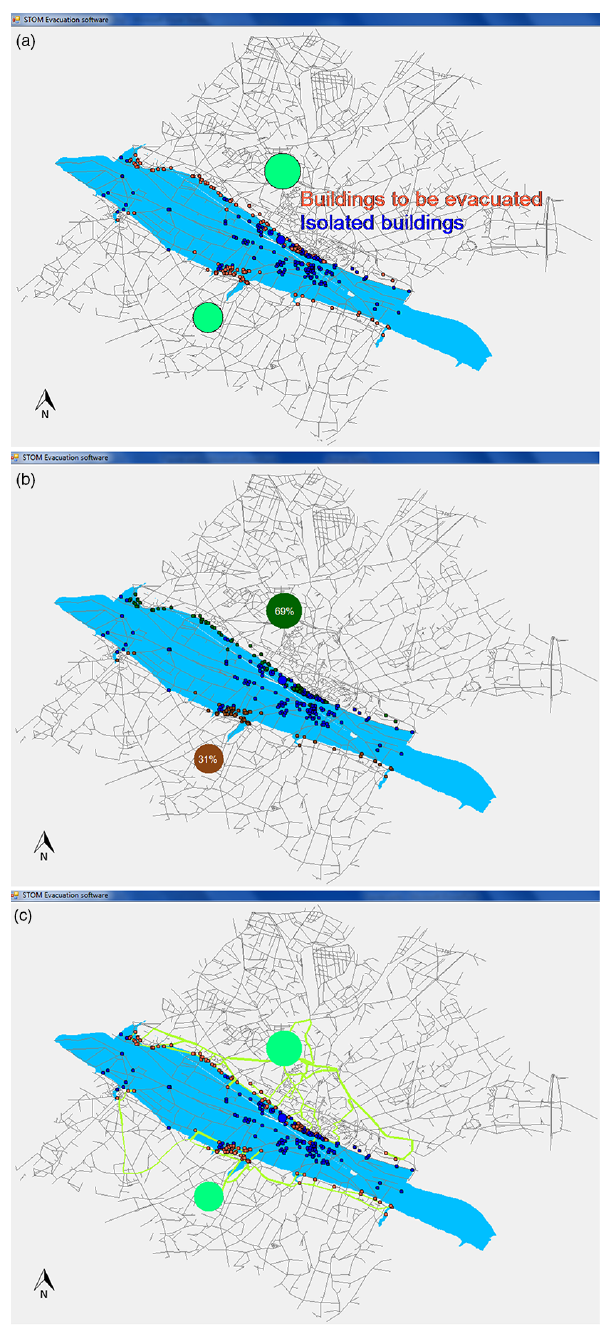
Figure 17. (a) shows the buildings to be evacuated (in red) and iso- lated buildings (in blue) 125h after the beginning of the flood, while (b) shows assignment of buildings to safety points. (c) illustrates the three best evacuation paths among buildings and shelters.